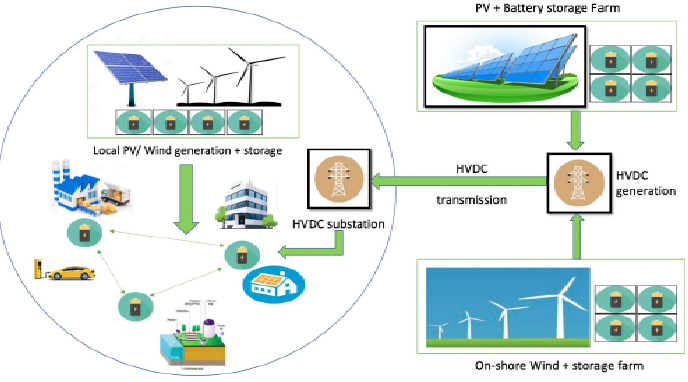
Figure 2. 100% DC Grid Powered by PV, and or Wind and Battery [15] .